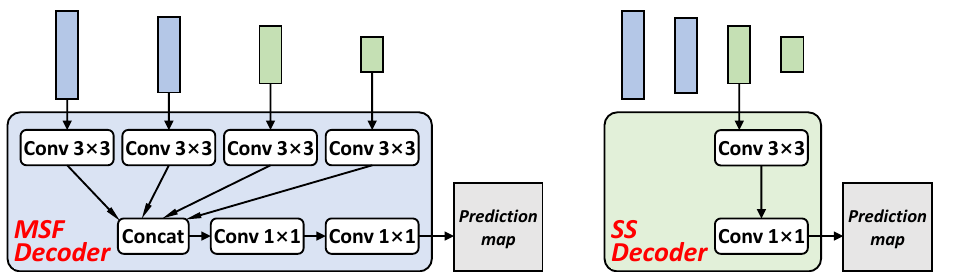
Figure 6. Multi-scale fusion decoder and single-scale decoder.